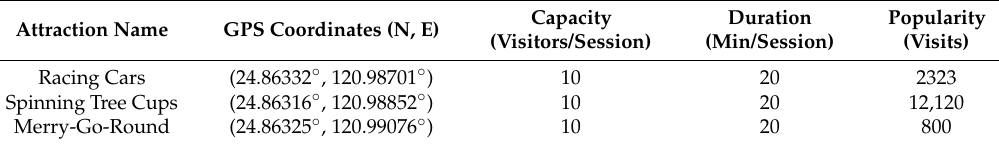
Table 1. Attraction parameters in the experiments.